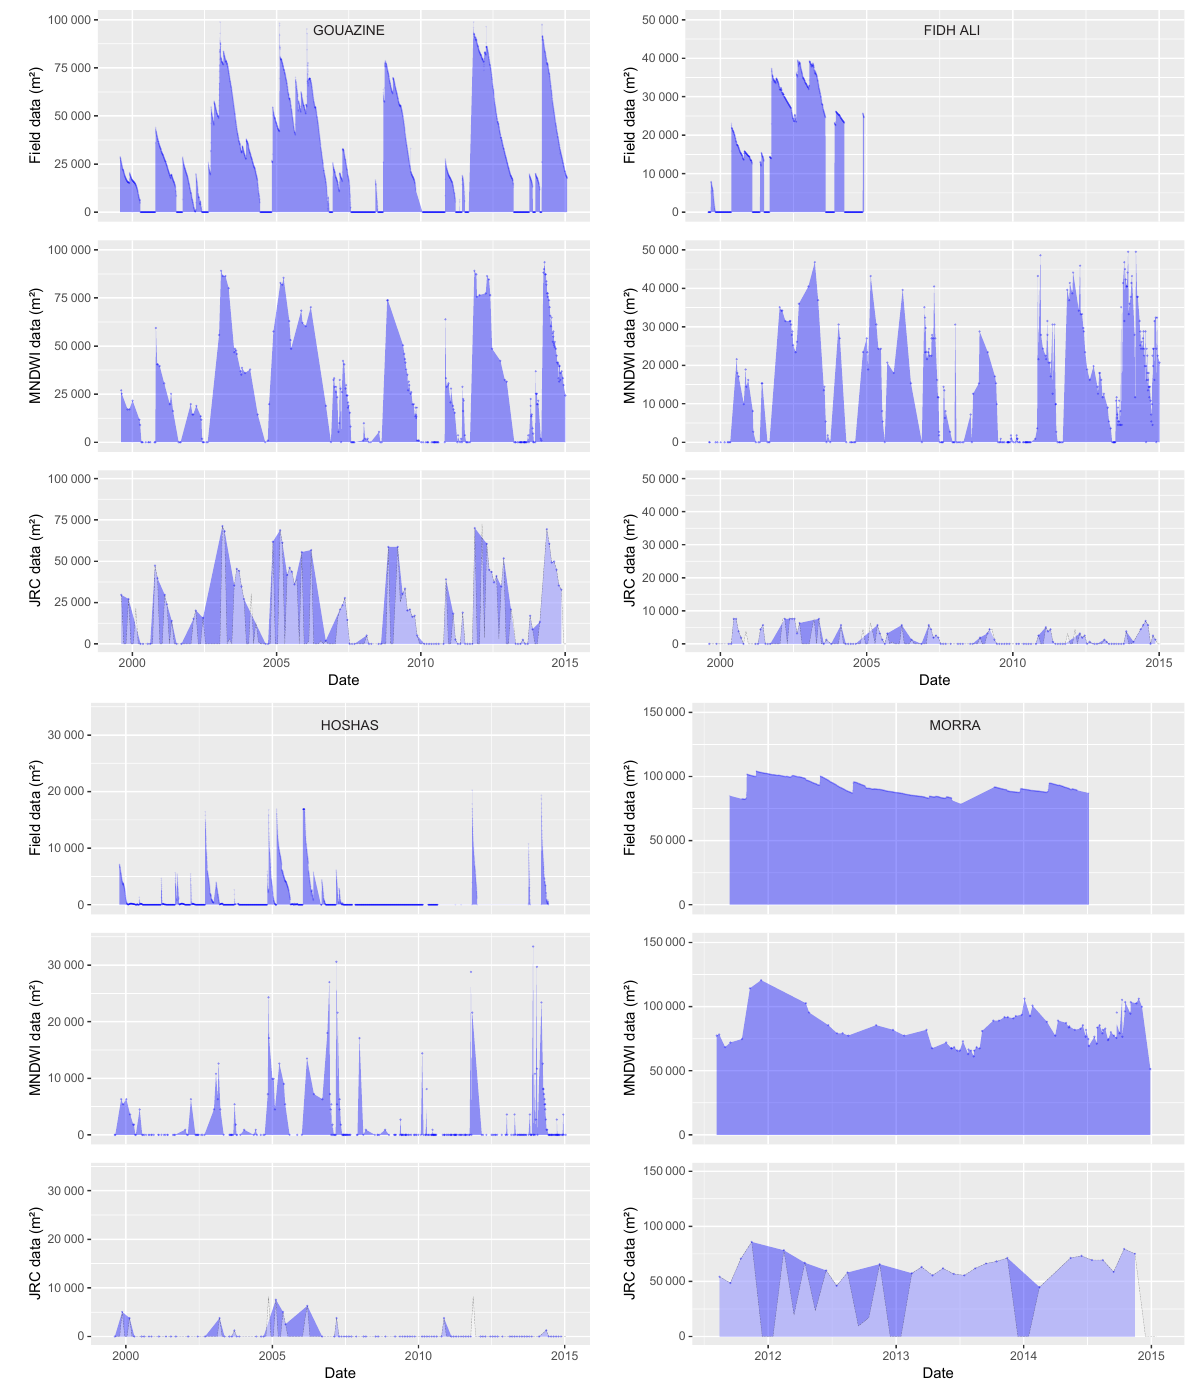
Figure 15. Surface water extent dynamics from field data and remote sensing over 1999–2015 for four lakes. JRC data (Pekel et al., 2016) are filtered to images with less than 25% NA over the lake cell (the complete JRC datasets are represented in pale